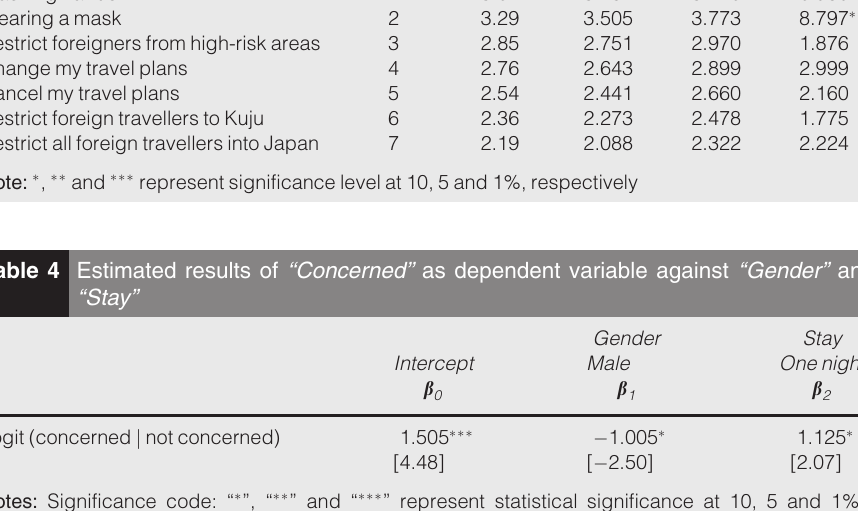
Table 3 ANOVA in agreement with seven countermeasures by gender Countermeasure Rank Median Male Female F -value Washing hands 1 3.62